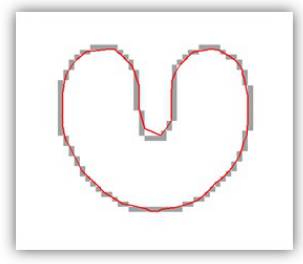
Figure 6. GVF-based parametric active contour model applied to an object with a concave boundary [21].